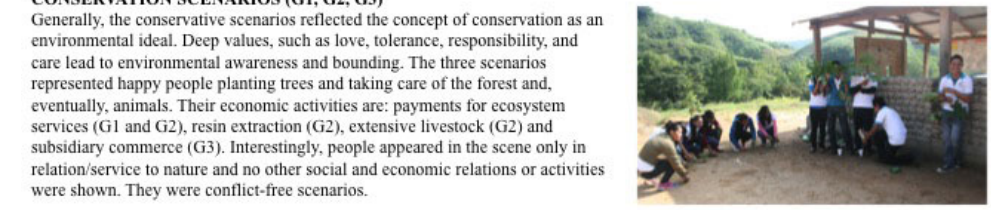
Fig. 2 . Summary of the different scenarios performed. Photos: two moments from the workshop (conservation scenario and diversified